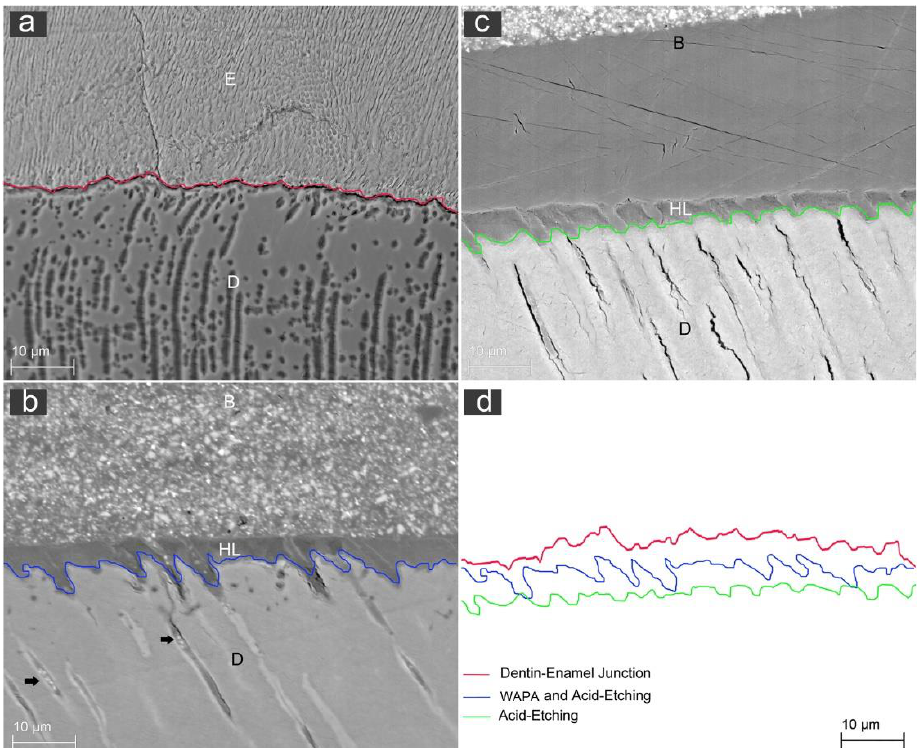
Figure 9. Representative SEM images for the qualitative evaluation of line profile at the interface between dentin and resin: ( a ) red-line profile of the dentin/enamel junction (DEJ) of a sound tooth; (E) enamel; (D) dentin. Mag 500×; ( b ) blue-line profile of the interface between dentin and resin for the WAPA group. (B) resin; (HL) hybrid layer; (D) dentin; black arrows: resin tags inside dentinal tubules. Mag 500×; ( c ) green-line profile of the interface between dentin and resin for the control group. (B) resin; (HL) hybrid layer; (D) dentin. Mag 500×; ( d ) comparison among line profiles. The similarity between the red and blue profile lines and the substantially different trend for the green line appears evident.